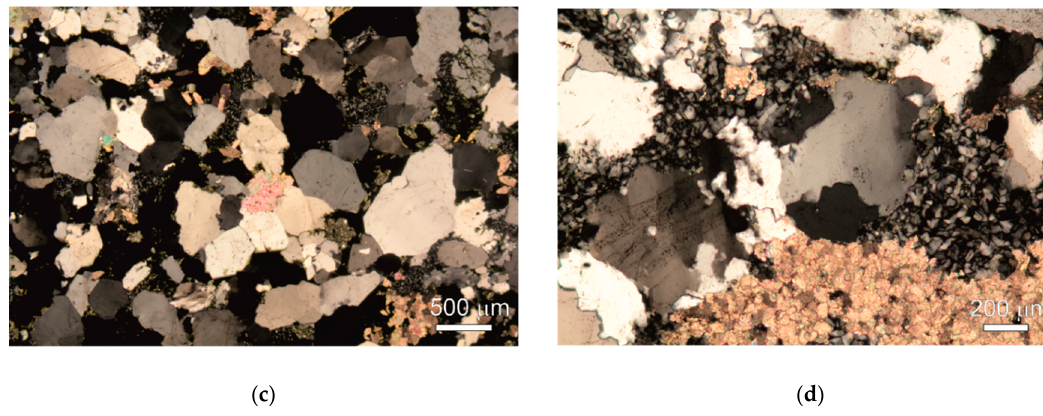
Figure 1. Micrographs of the stone fabric taken with a polarized light microscope: ( a ) Fabric of St. Margarethen Limestone with nearly equally distributed debris of coralline red algae and rotaliide foraminifers; ( b ) detail of the so-called dogtooth cement displayed as yellow binder between the microfossils; ( c ) fabric of Schlaitdorf Sandstone mainly consisting of quartz beneath feldspar and carbonate (pinkish colour), with planar to lobate grain boundaries, and ( d ) detail of the grain boundaries, the kaolinite matrix and sparitic carbonate.